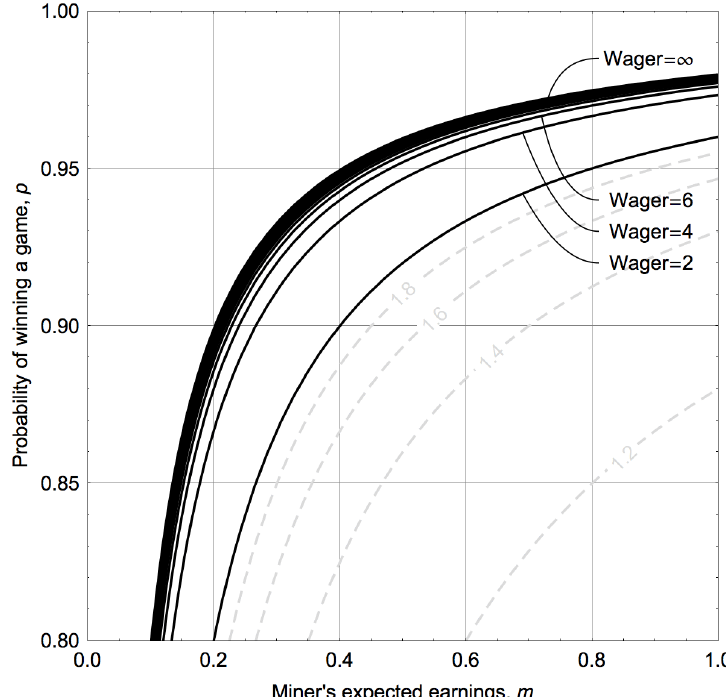
Fig. 1. Minimum wager 𝑤 required to profitably game the “lottery with a delayed resolution” contract. ℎ = 0.98 , logarithmic scale for 𝑚 and 𝑝 . Black curves at different constant values of 𝑤 are